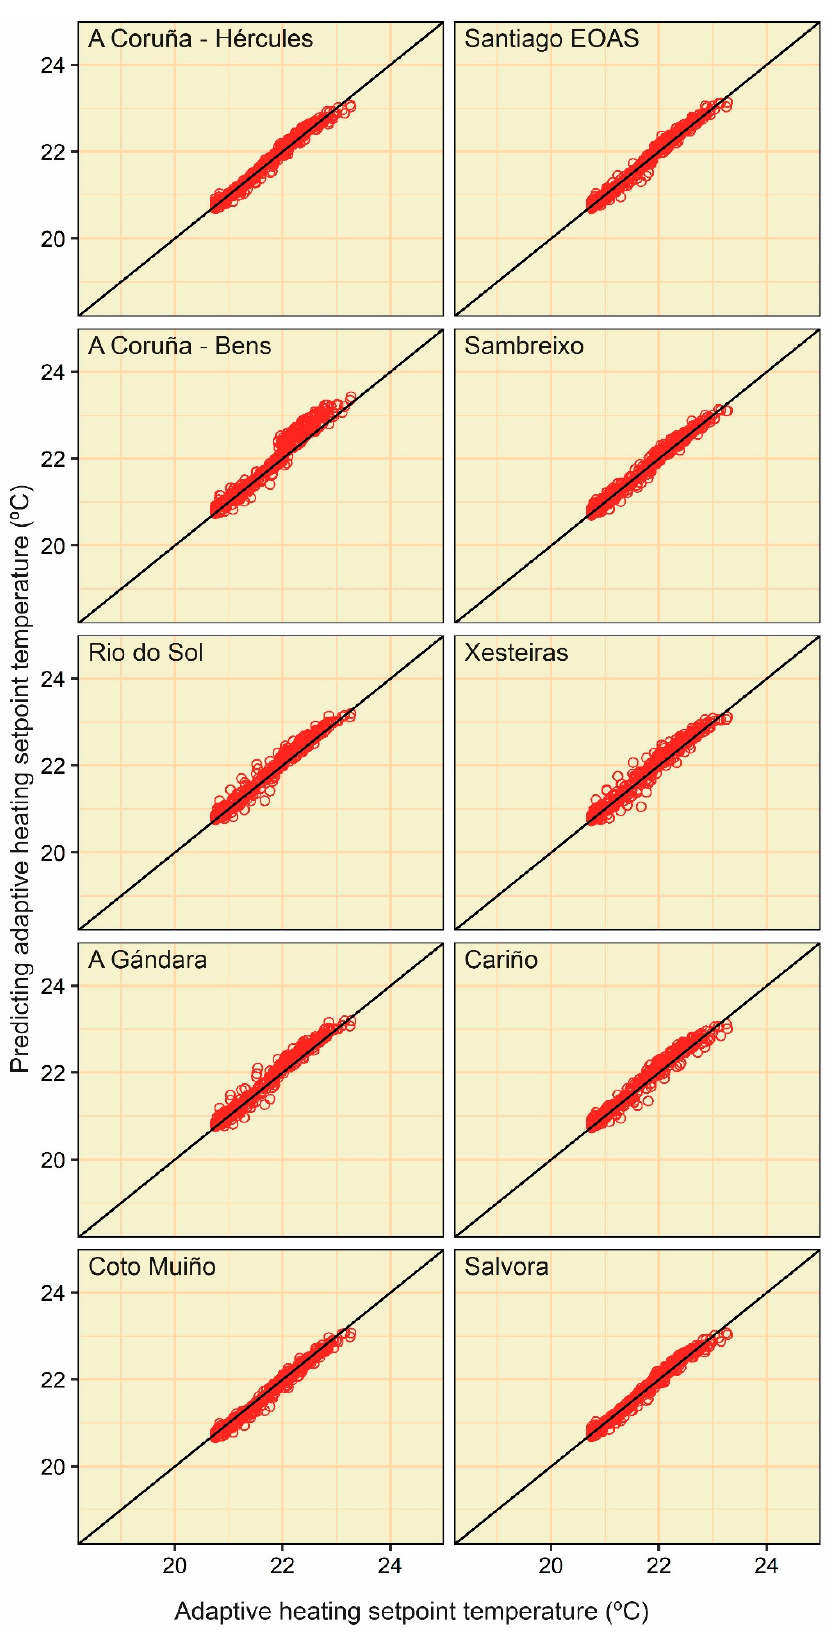
Figure A17. Point clouds between the actual and predicting adaptive heating setpoint temperature values (category II) of the MLP (approach 1).